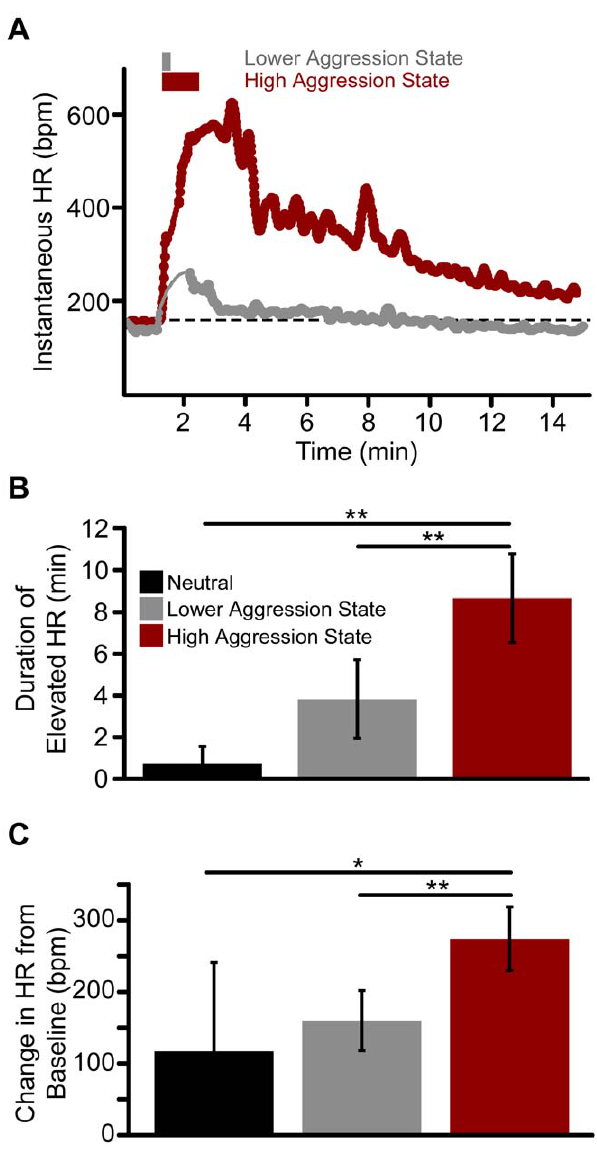
Figure 9. Magnitude and duration of elevated heart rate scales to the level of vocal aggression. ( A ). Instantaneous heart rate (beats per min, bpm) during two 15-min tactile irritation trials from the same bat. A short duration irritating stimulus (15 s) resulted in a lower aggression state ( grey ) and a smaller and shorter increase in heart rate. In contrast, a longer duration (60 s) tactile stimulus resulted in a high aggression state ( red ) and a larger increase in heart rate that remained significantly elevated throughout the trial. Aggressive behavioral states were classified based on the emitted syllable types. Dashed black line is the mean baseline rate calculated during the first 60 s of the trial. Grey and red rectangles above plot indicate timing and duration of the tactile stimulation. On average, heart rate remained elevated for a longer duration ( B ) and showed a greater magnitude of change ( C ) during high aggression states ( red ) than lower aggression ( grey ) or neutral states ( black ). Bars represent mean 6 2 standard errors (n=39 trials, 4 bats). Asterisk, p , 0.05. Double asterisk, p ,